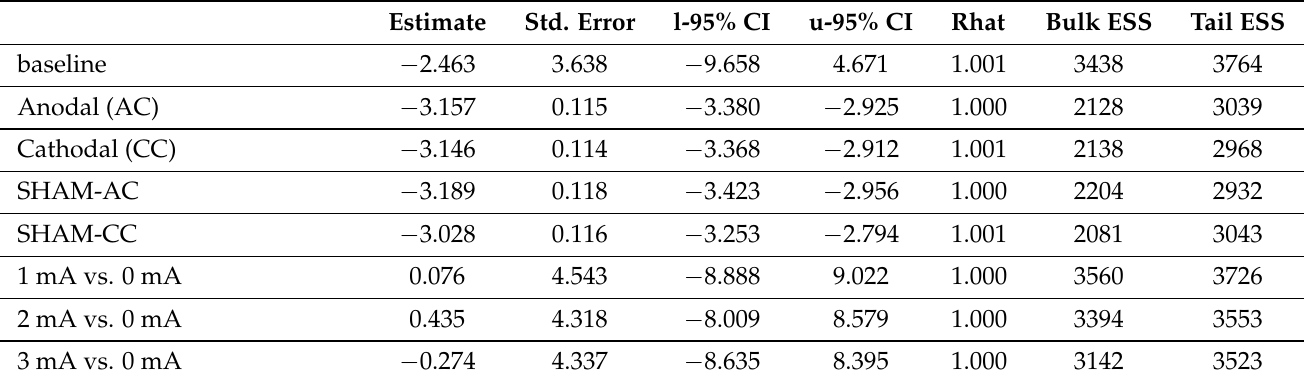
Table A2. Bayesian GLMM—Fixed & Random effects